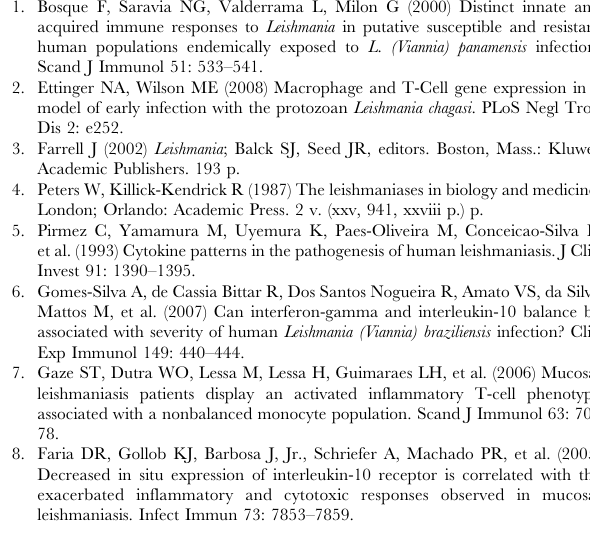
Table S1 Experimental conditions and oligonucleotides used for qPCR assays. Shown are the primers and PCR conditions used for quantitative PCR experiments. All oligonucle- otide sets employed were validated using human total RNA (Clontech). IL-1 b forward and reverse oligonucleotide primers were based upon those previously described by Goll, et al. [95]. GAPDH oligonucleotide primers were previously described by Carraro, et al. [96]. Remaining oligonucleotides primers were designed using BioEdit (http://www.mbio.ncsu.edu/bioedit/bioedit.html), Primer Express Software (Applied Biosystems), OligoTech (Oligos Etc. Inc.